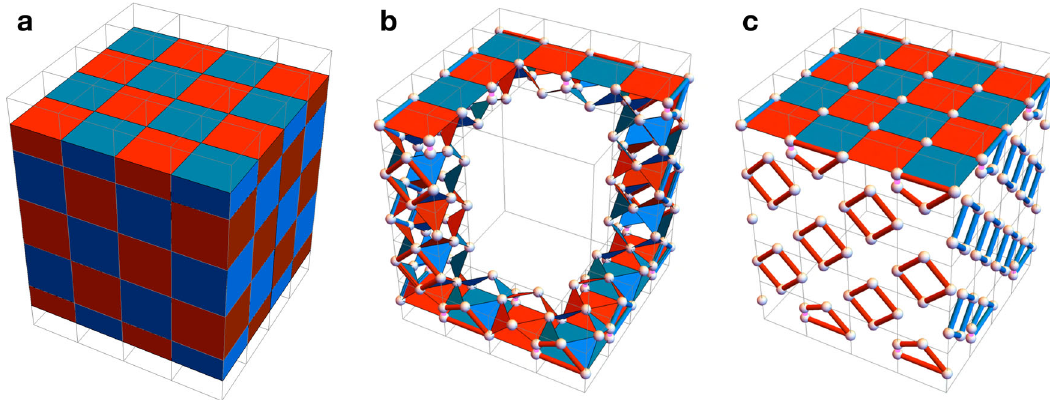
Fig. 1 | First glance at the 3D STC. a The cubic lattice with open boundary con- ditionsandthelinearsize L =4.Itscubicvolumescanbecoloredinredandblueina checkerboard pattern. b , c We de fi ne the 3D STC on the lattice L * cub (described in the section “ Results ” ) according to Fig. 2a, c. We illustrate the support of some of the X - and Z -type gauge operators (red and blue shapes). Qubits are placed on the edges of the cubic lattice (represented by white dots), with additional qubits near